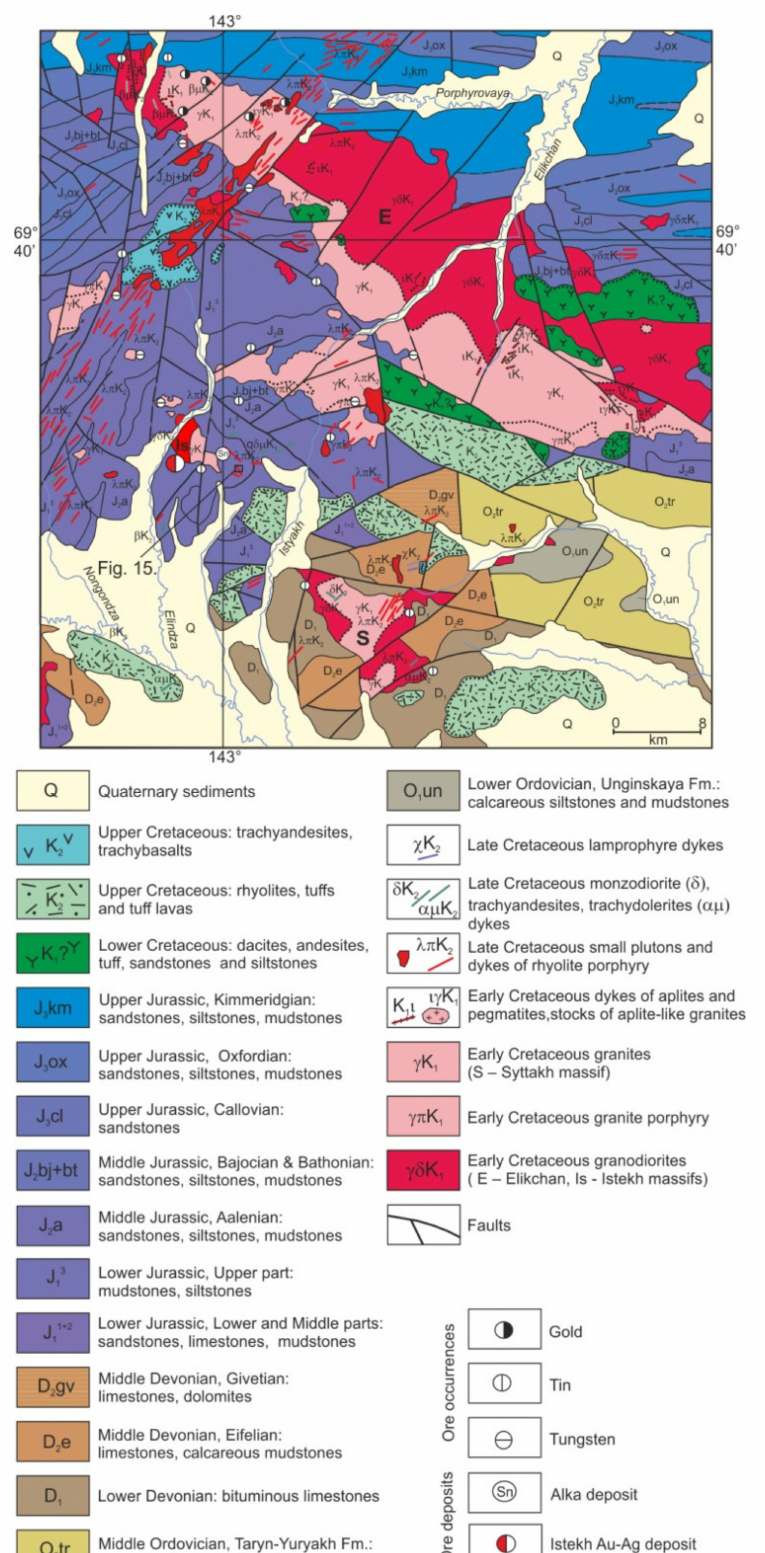
Figure 4. Geological map of the Elikchan and Istekh ore fields, modified from